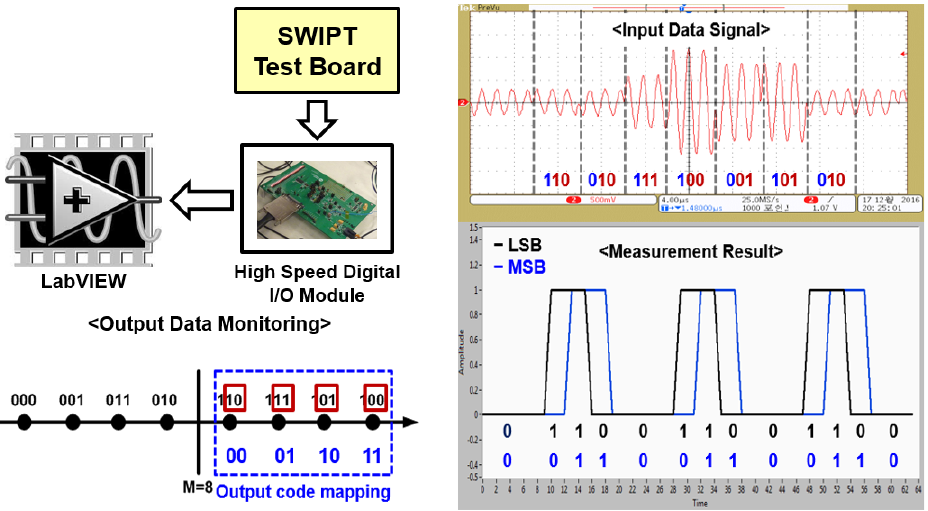
Figure 15. Measurement results of 900 MHz SWIPT amplitude detection path (The meaning of the Korean is the same as they are in Figure